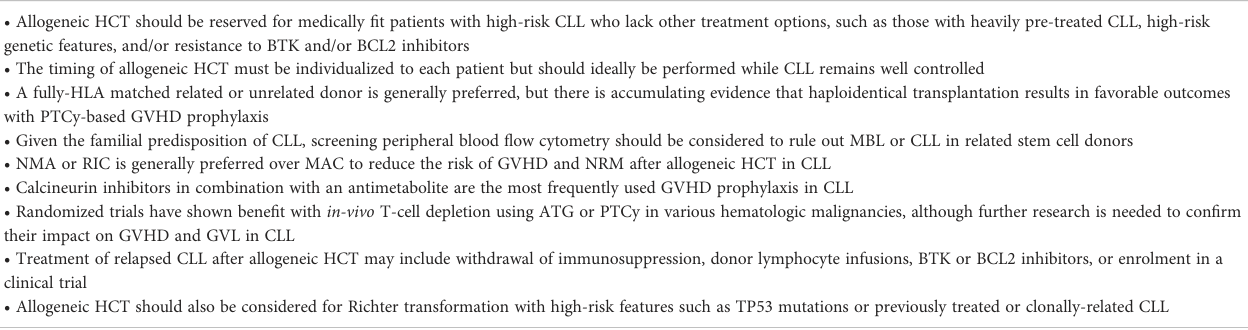
TABLE 1 Evidence-based practice recommendations for allogeneic HCT in CLL. (cid:129) Allogeneic HCT should be reserved for medically fi t patients with high-risk CLL who lack other treatment options, such as those with heavily pre-treated CLL, high-risk genetic features, and/or resistance to BTK and/or BCL2 inhibitors (cid:129) The timing of allogeneic HCT must be individualized to each patient but should ideally be performed while CLL remains well controlled (cid:129) A fully-HLA matched related or unrelated donor is generally preferred, but there is accumulating evidence that haploidentical transplantation results in favorable outcomes with PTCy-based GVHD prophylaxis (cid:129) Given the familial predisposition of CLL, screening peripheral blood fl ow cytometry should be considered to rule out MBL or CLL in related stem cell donors (cid:129) NMA or RIC is generally preferred over MAC to reduce the risk of GVHD and NRM after allogeneic HCT in CLL (cid:129) Calcineurin inhibitors in combination with an antimetabolite are the most frequently used GVHD prophylaxis in CLL (cid:129) Randomized trials have shown bene fi t with in-vivo T-cell depletion using ATG or PTCy in various hematologic malignancies, although further research is needed to con fi rm their impact on GVHD and GVL in CLL (cid:129) Treatment of relapsed CLL after allogeneic HCT may include withdrawal of immunosuppression, donor lymphocyte infusions, BTK or BCL2 inhibitors, or enrolment in a clinical trial (cid:129) Allogeneic HCT should also be considered for Richter transformation with high-risk features such as TP53 mutations or previously treated or clonally-related